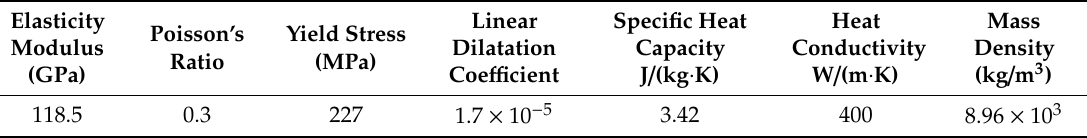
Table 1. Material properties of the workpiece.